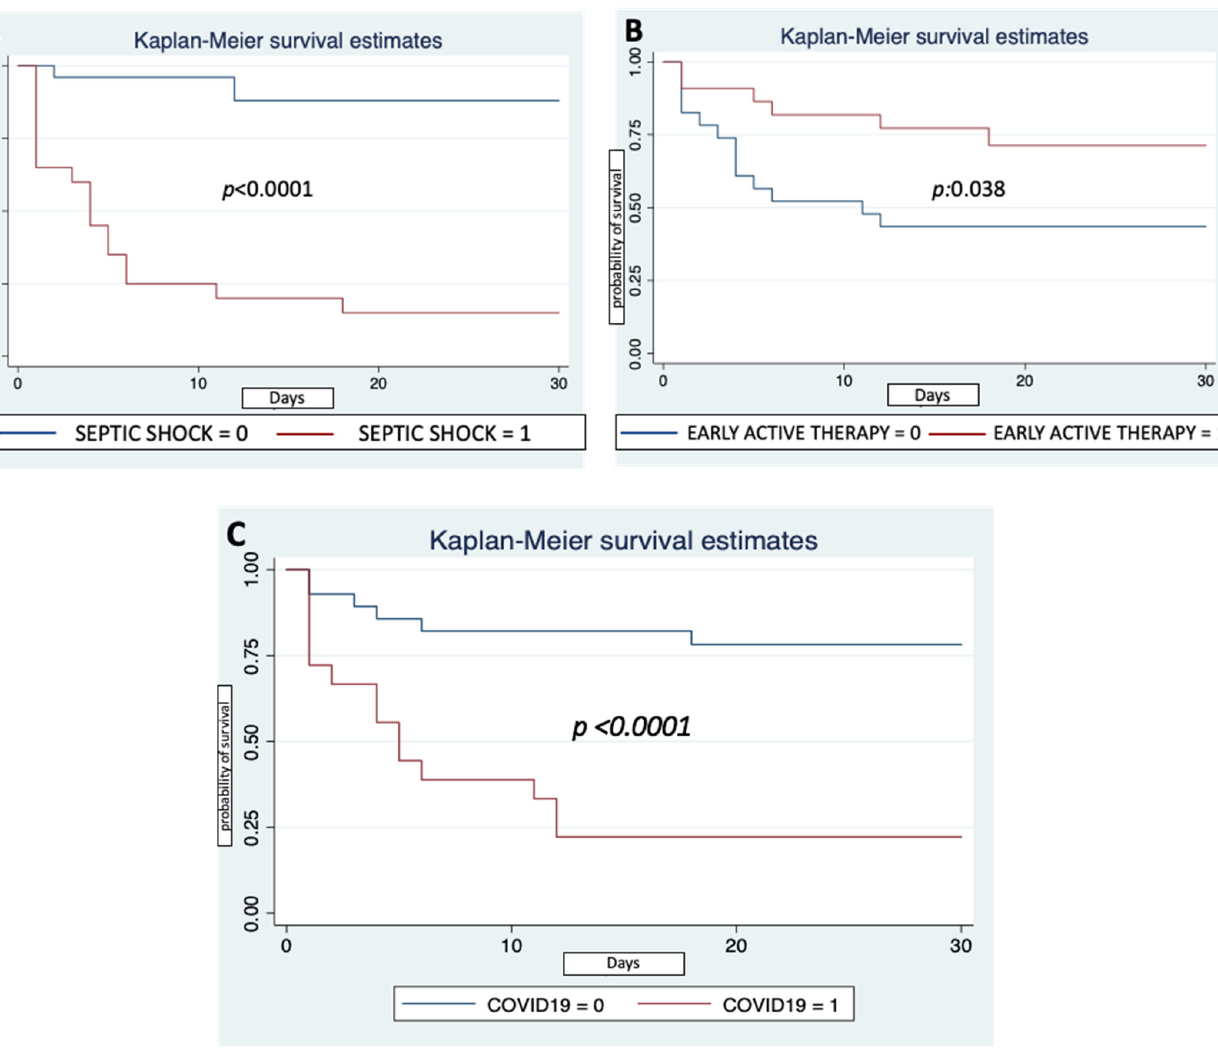
Figure 1. Cumulative proportions on overall 30-day mortality estimates from MDR-GN BSI onset. ( A ), between patients with (red line) or without (blue line) septic shock at the BSI onset; ( B ), between patients that received early active therapy (red line) and who did not receive it (blue line); ( C ), between pre-pandemic patients (blue line) and COVID-19 patients (red line). Axis X: number of days from BSI onset; axis Y: probability of survival from BSI onset. Abbreviations : MDR-GN: multi-drug-resistant Gram-negative bacteria; BSI: bloodstream infection; early active therapy: at least one in vitro active drug within the first 24 h.